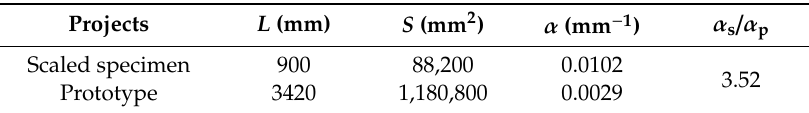
Table 1. The section